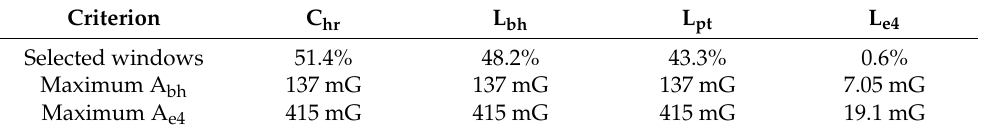
Table 1. Proportion of selected 60 s time windows over the whole dataset (upper line), and maximum activity level in chest (A bh ) and wrist (A e4 ) in the selected time windows (lower lines). Over the whole dataset (i.e., without window selection), the maximum level for A bh was 382 mG and the maximum level for A e4 was 825 mG. Column N ◦ 2 corresponds to window selection from BioHarness SQI: C hr (Equation (7)). Columns N ◦ 3, 4, 5 correspond to window selection from the Lack Index of each IBI signal: L bh , L pt and L e4 (Equation